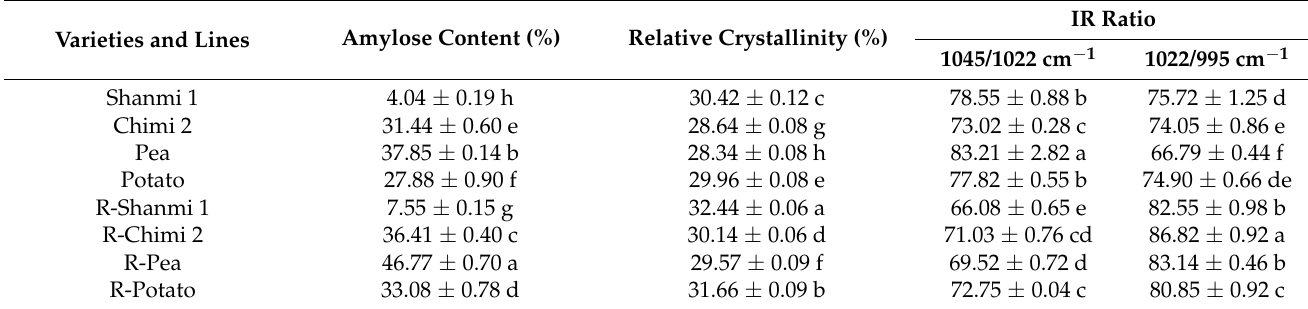
Table 2. Amylose content, relative crystallinity, and IR ratio of NS (natural starch) and RS (resistant starch). Varieties and Lines